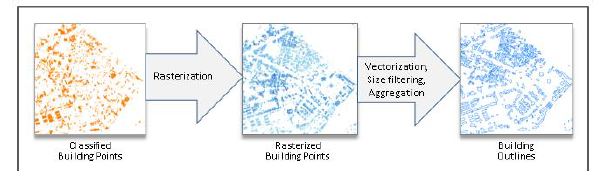
Figure 3. The building extraction methodologies 3.3.2